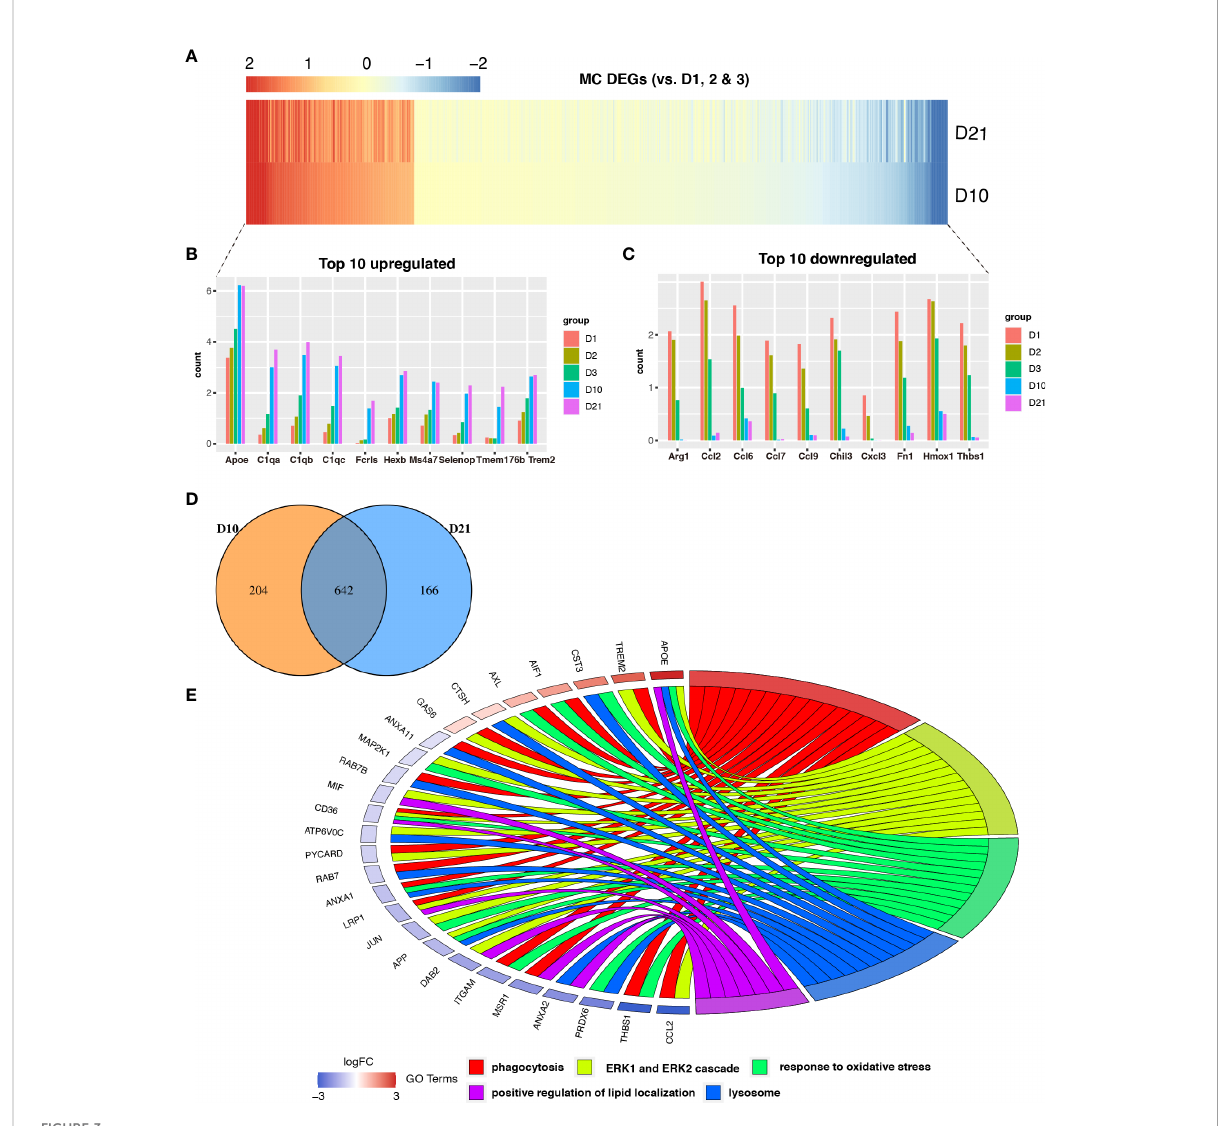
FIGURE 3 Analysis of differential gene expression in macrophages following spinal cord injury (SCI). (A) Heatmap showing differentially expressed genes (DEGs) between macrophages sampled 10 days post injury (dpi) and 21 dpi compared with macrophages sampled in the fi rst three days. (B, C) Bar graph showing the top 10 upregulated and downregulated genes in macrophages sampled 10 dpi and 21 dpi. (D) Venn diagram showing an overlap between genes that were differentially expressed between macrophages sampled 10 dpi and those sampled 21 dpi. (E) Chord plot showing the gene ontology (GO) of biological processes associated with overlapping DEGs in macrophages sampled 10 dpi and 21